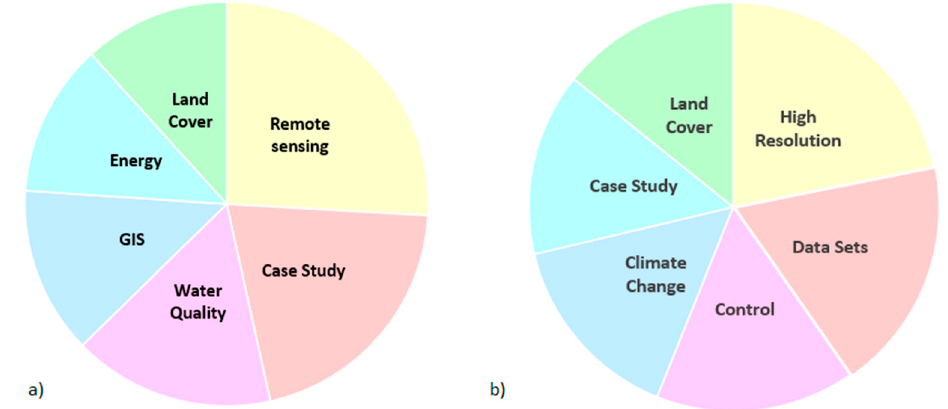
Figure 2. Most repeated topics of papers published for ( a ) GIS + environmental monitoring and ( b ) remote sensing + environmental monitoring in the last decade according to [1].